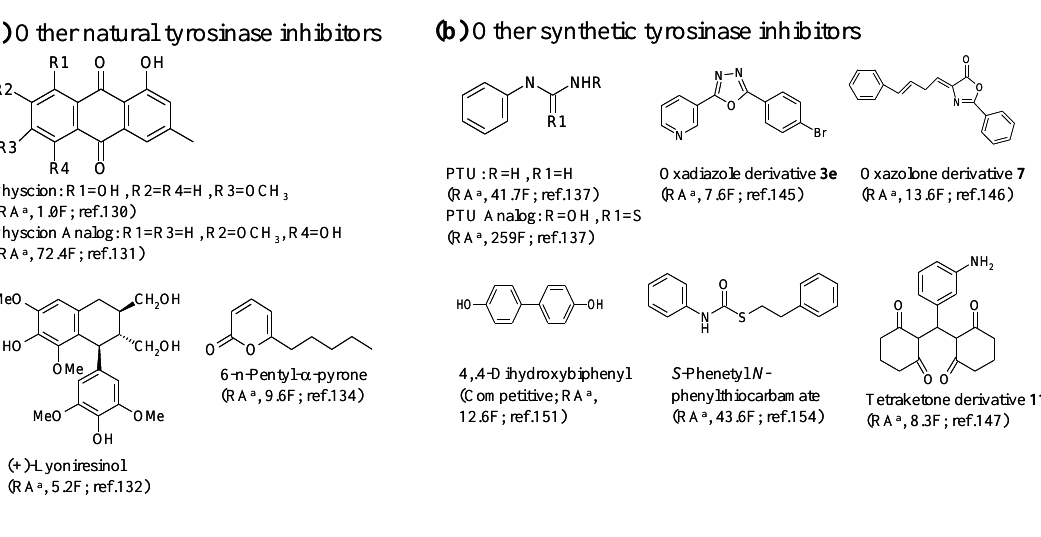
Figure 6. Chemical structures of other tyrosinase inhibitors from natural ( a) or synthetic (b) sources. RA a and RA b have the same meanings as those of Figure